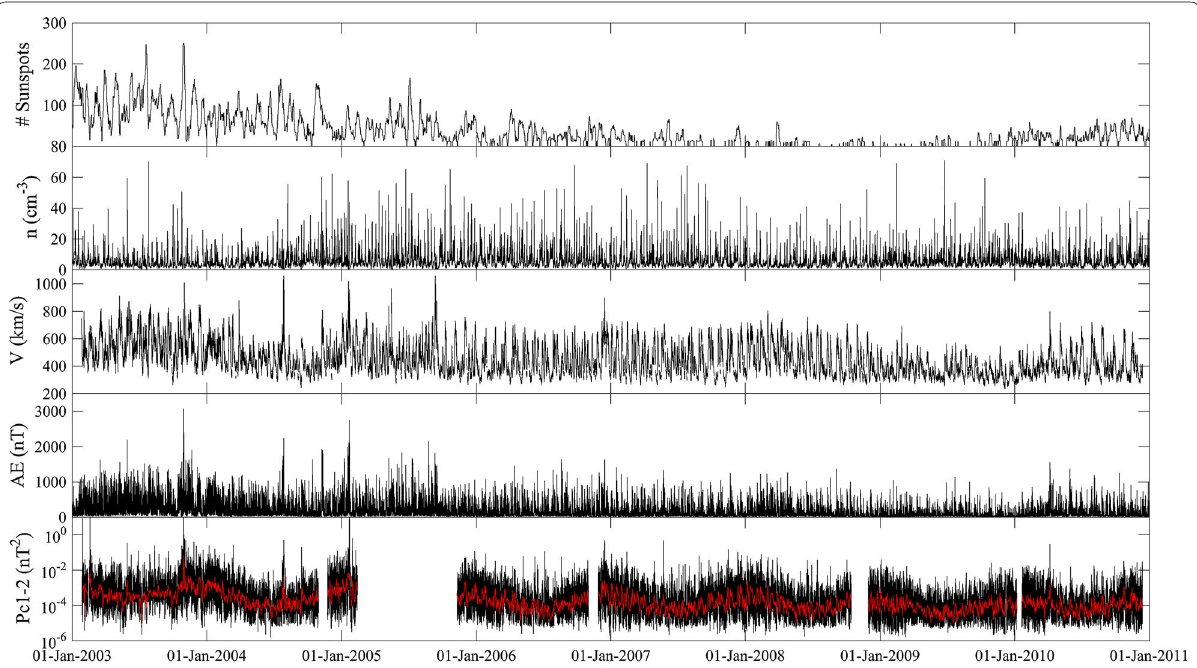
Fig. 1 Interplanetary and geomagnetic conditions from 2003 to 2010. From the top: sunspot number, 30-min averages of SW speed and density, and 30-min averages of AE index and total power